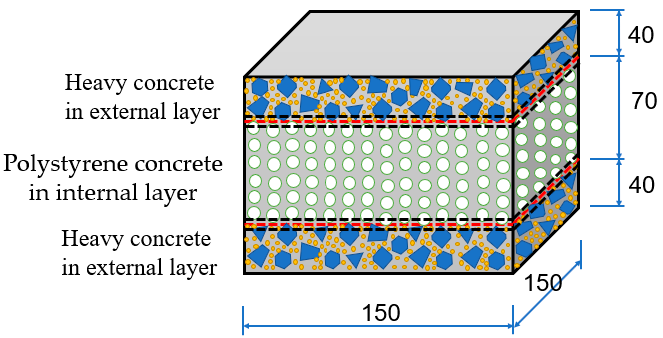
Figure 1. The scheme of 150 × 150 × 150 mm cubical-shaped sample. Experiments of microscopic study of the formation and geometric characteristics of the contact zone between layers of various concrete of the external and internal lay- ers were carried out with a stereoscopic microscope MBS10 on three-layer samples of 150 × 75 × 10 mm (Figures 2b and 3a) and a Quanta 250 scanning electron microscope on samples of 40 × 20 × 10 mm (Figures 2c and 3b). These two types of samples were cut from cubical-shaped three-layer samples of 150 × 150 × 150 mm (Figure 2a).